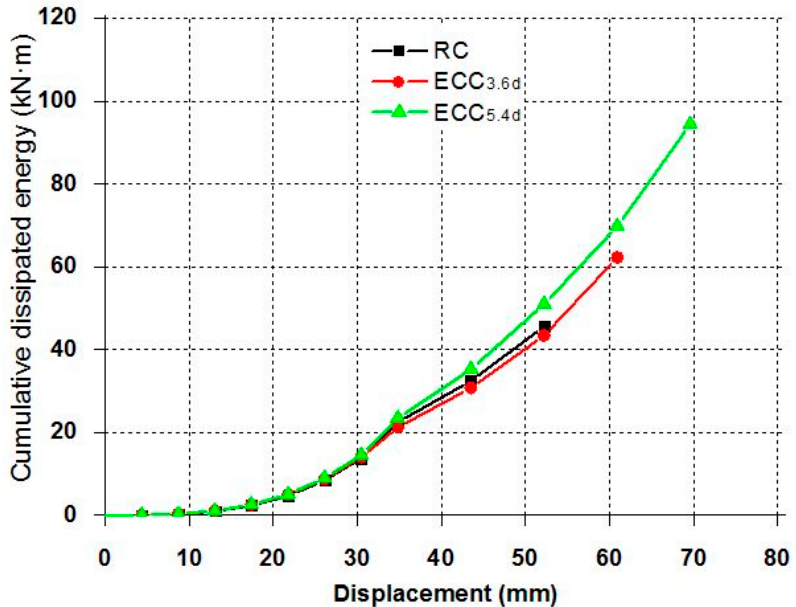
Figure 9. Cumulative dissipated energy of each specimen.